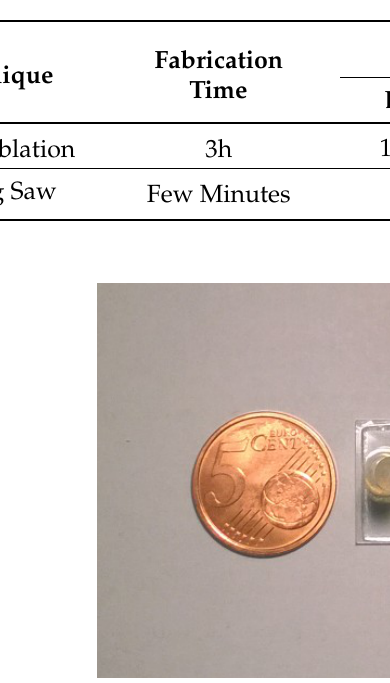
Table 1. Summary of the key parameters for the droplet generators realised with the two micromachining techniques presented in this paper.